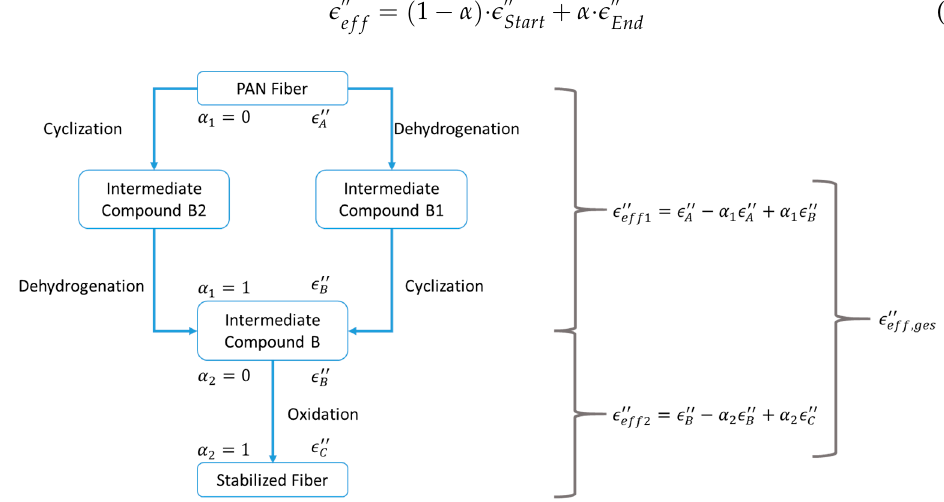
Figure 8. Diagram showing linkage between degree of conversion and dielectric loss during the stabilization stage.